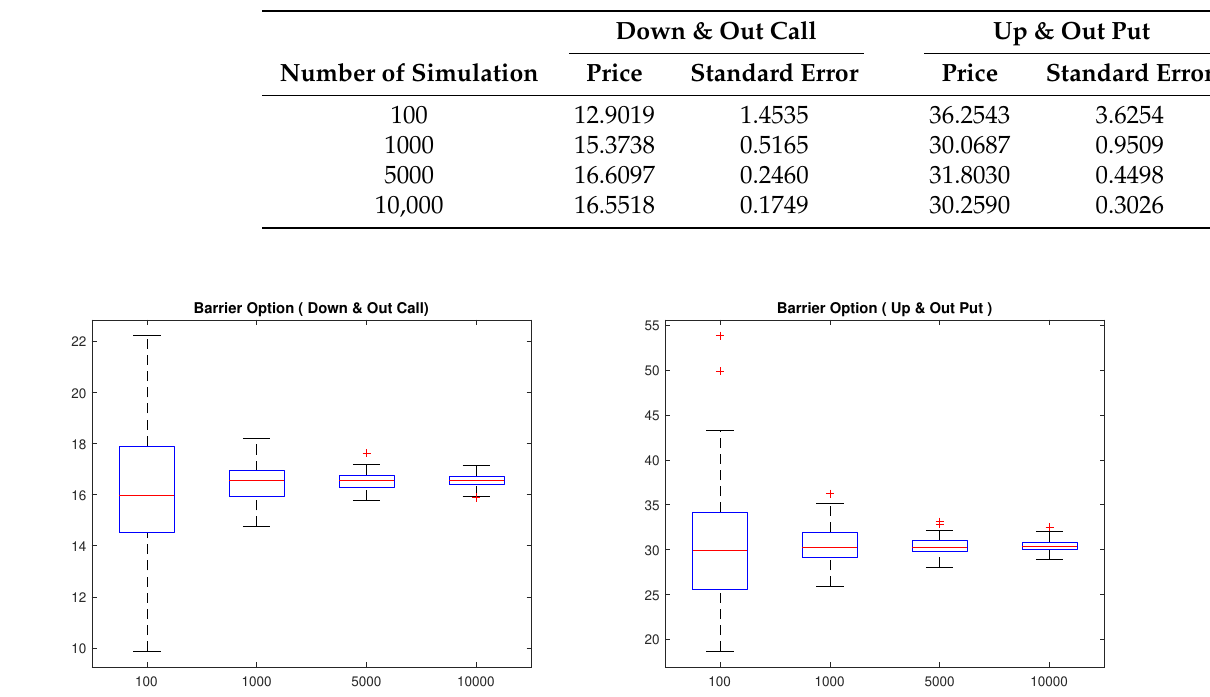
Table 10. MCS prices and standard errors for the down-and-out call and the up-and-out put.